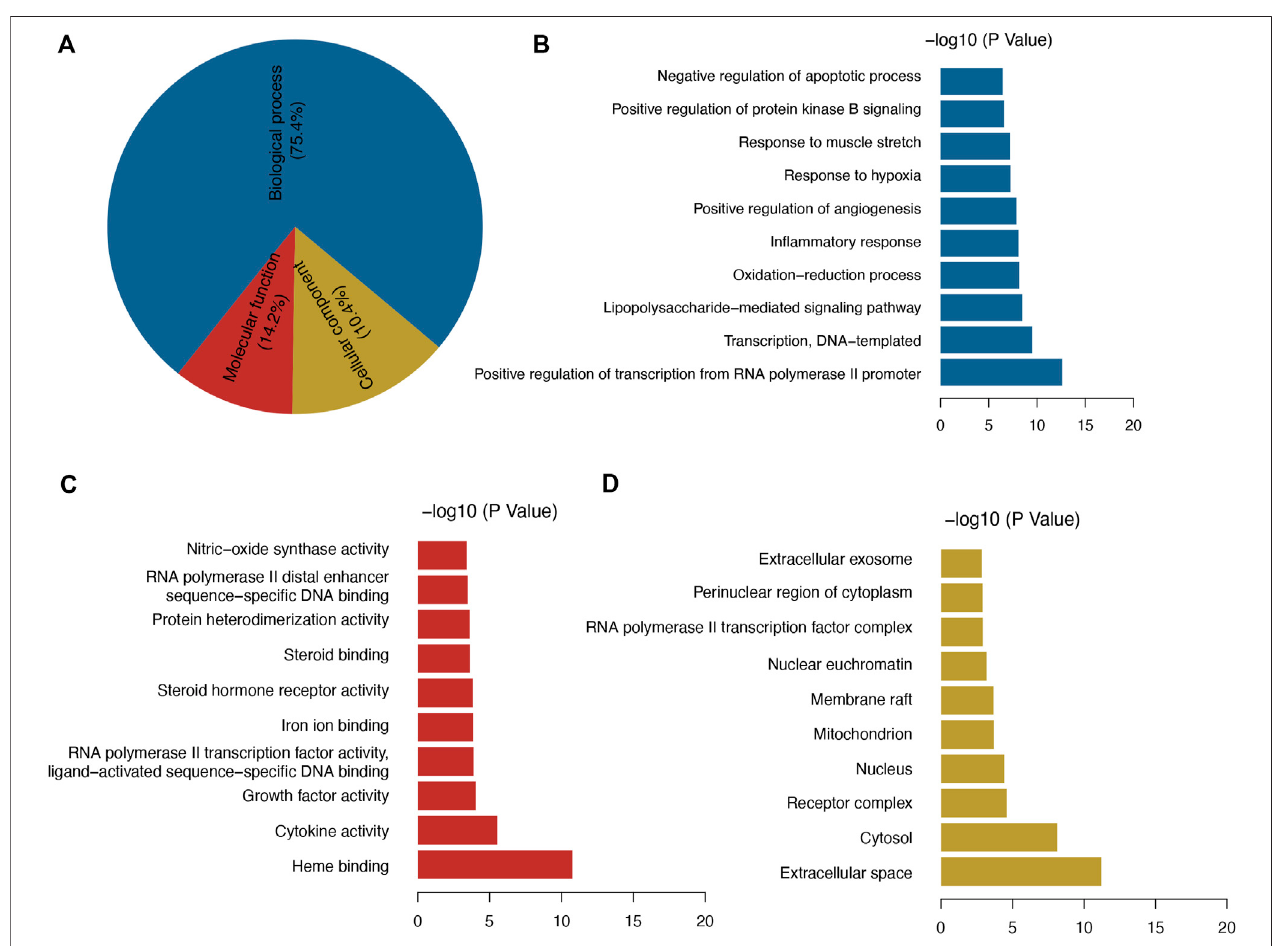
FIGURE 3 | (A) GO enrichment analysis, and (B – D) top 10 signi fi cant GO enrichment terms in categories BP, MF, and